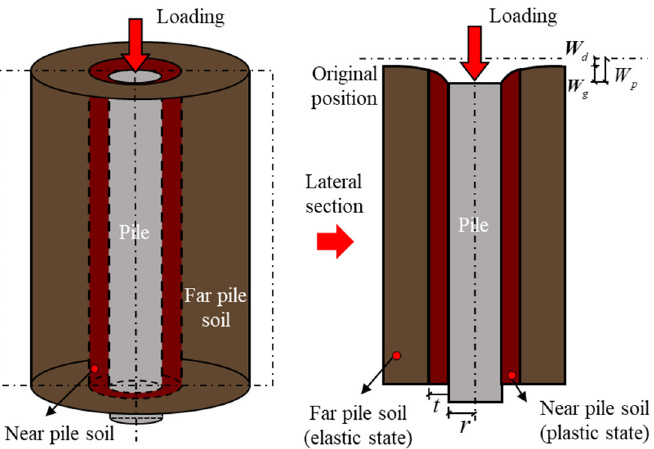
Figure 1. Schematic diagram of the shear deformation and slip between pile and soil.